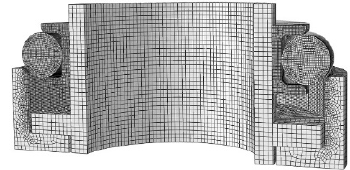
Figure 6. Finite element meshed model.